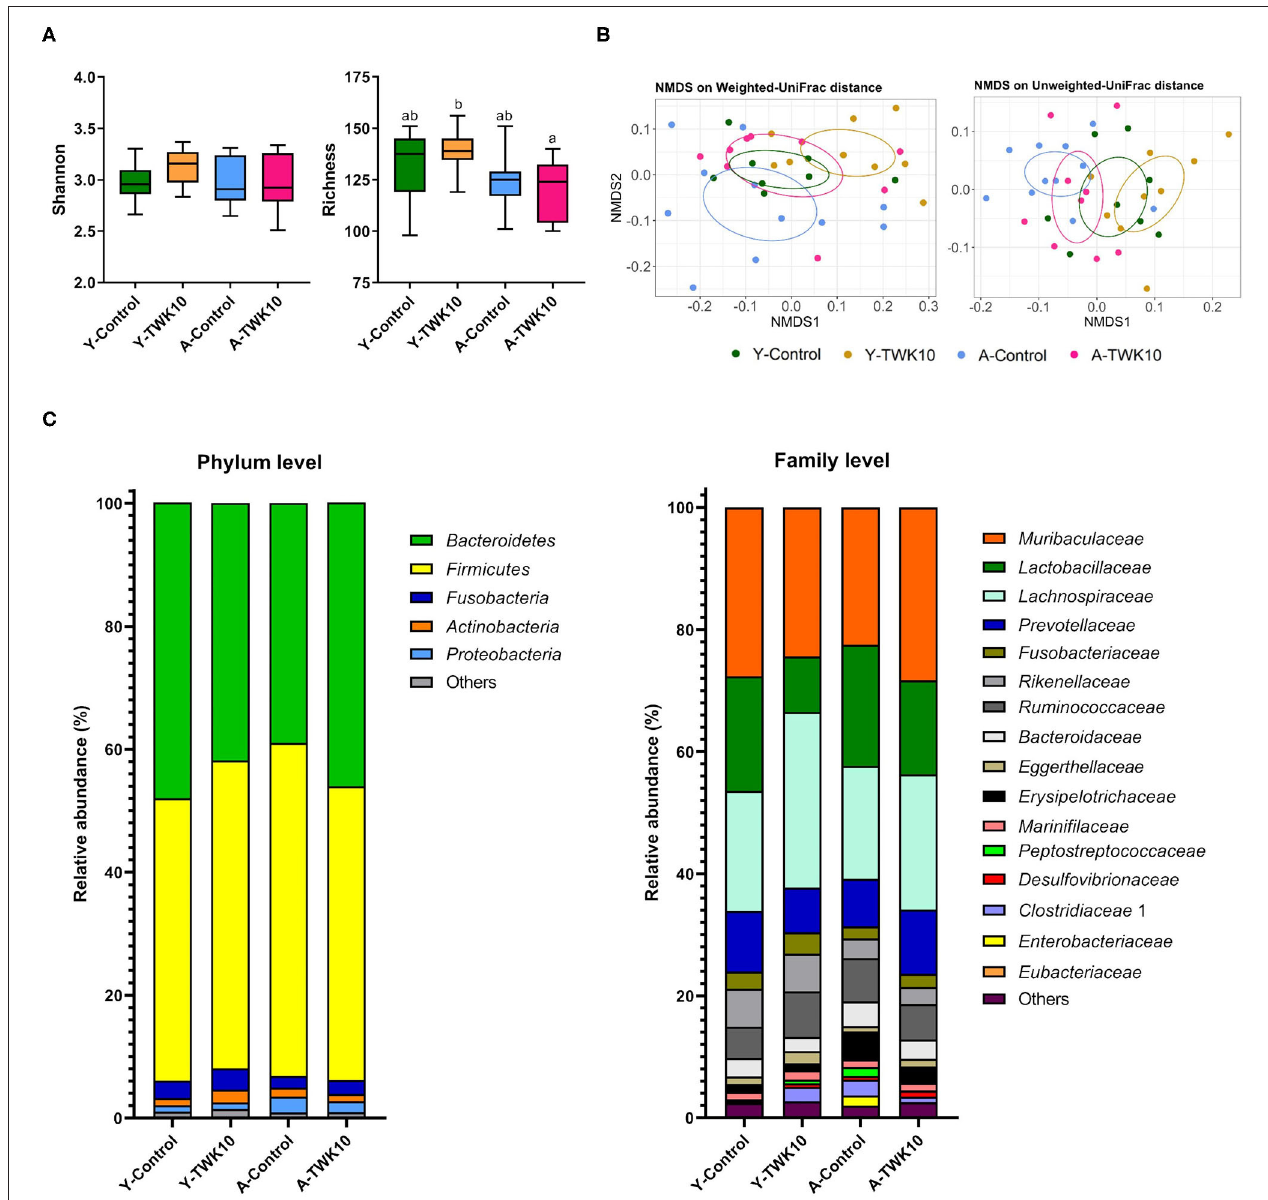
FIGURE 4 | Modulation of gut microbial composition by Lactobacillus plantarum TWK10. Gut microbiota signatures were expressed in terms of (A) Alpha-diversity (Shannon and Richness indices). The box plots show the smallest and largest values, 25 and 75% quartiles and the median, (B) Beta-diversity represented by non-metric multidimensional scaling (NMDS) plots based on weighted and unweighted UniFrac distances, and (C) Cumulative bar chart of average relative abundance of bacterial taxa at phylum and family levels. Statistical differences among groups were analyzed by two-way ANOVA with post-hoc Tukey-Kramer test, and different letters (a, b, c) indicate significant differences between the groups, P < 0.05. Non-parametric data were statistically analyzed by Kruskal-Wallis test with Dunn’s test.